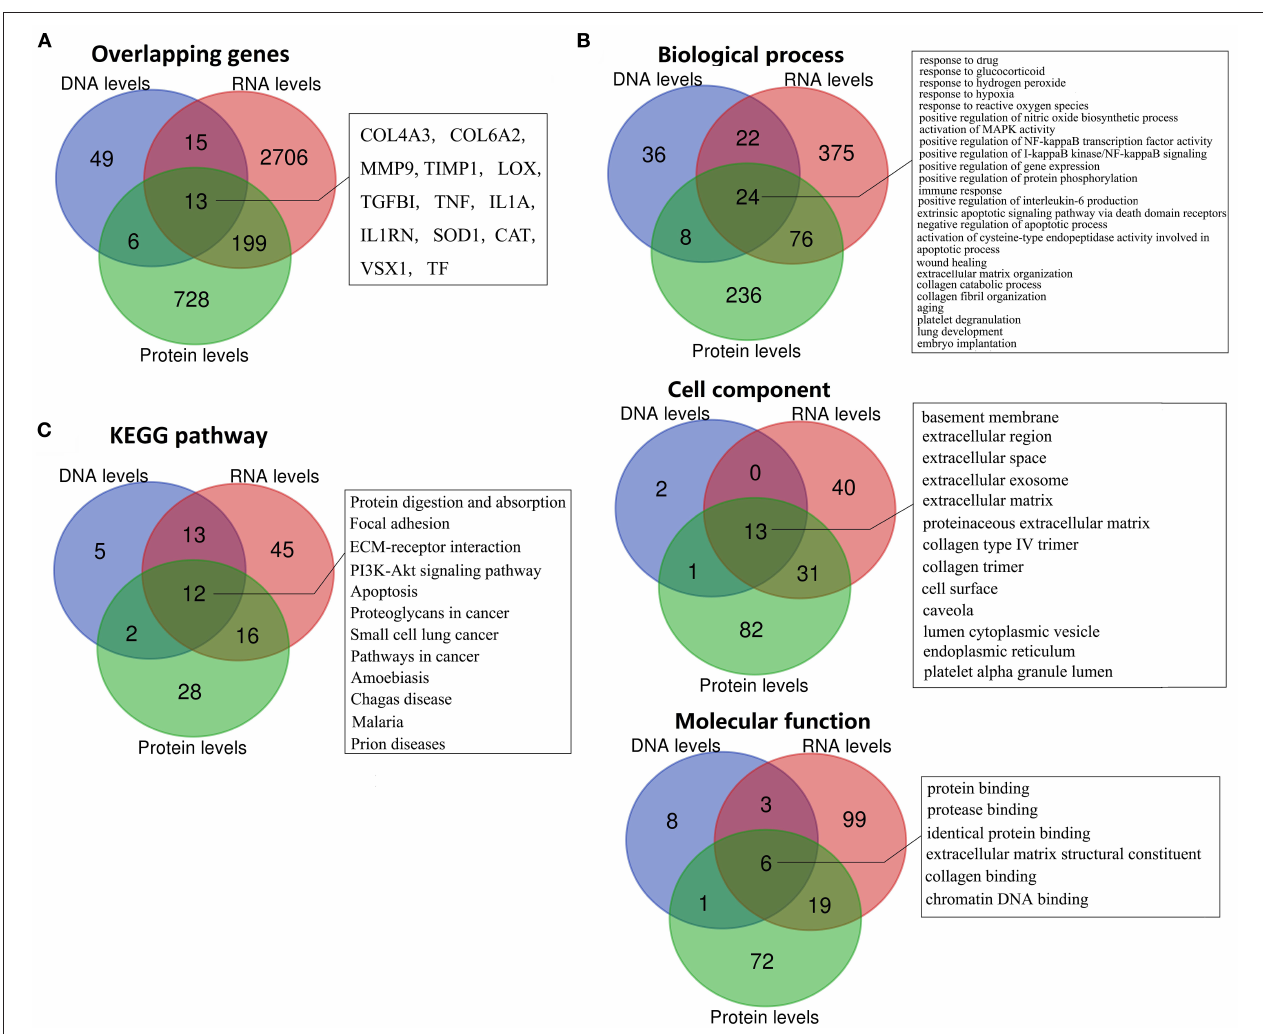
FIGURE 4 | Overlapping genes, GO terms, and KEGG pathways between multi-levels. (A) Overlapping genes; (B) Overlapping GO terms; (C) Overlapping KEGG pathways.